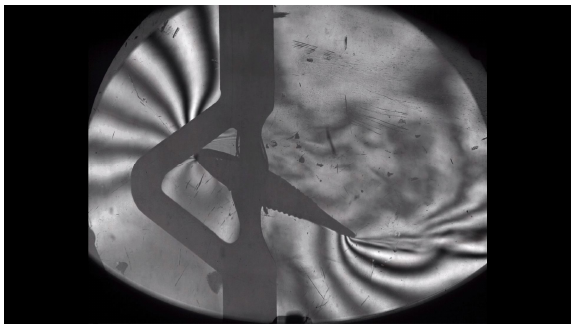
Fig. 13f. Interferogram, separated flow at upper airfoil